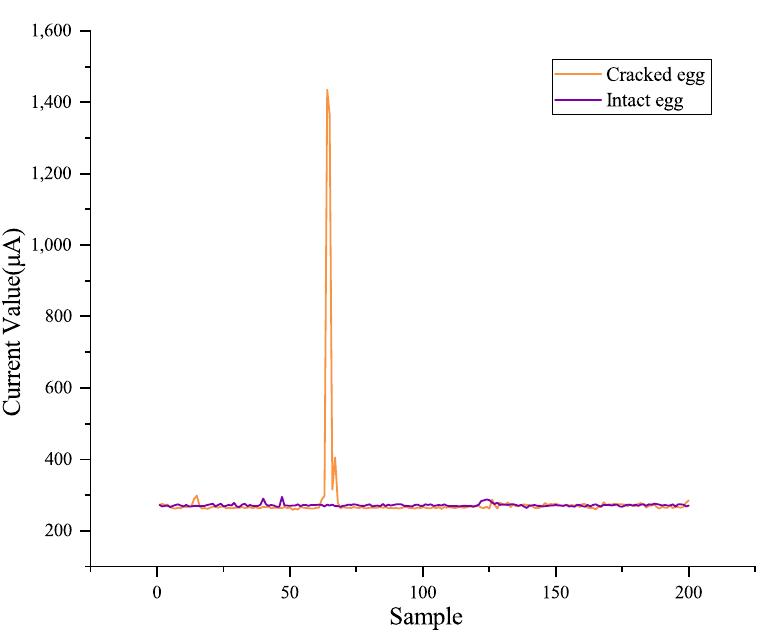
Figure 4. Comparison diagram of current measurement curves without cracks or cracked eggs under discharge electric